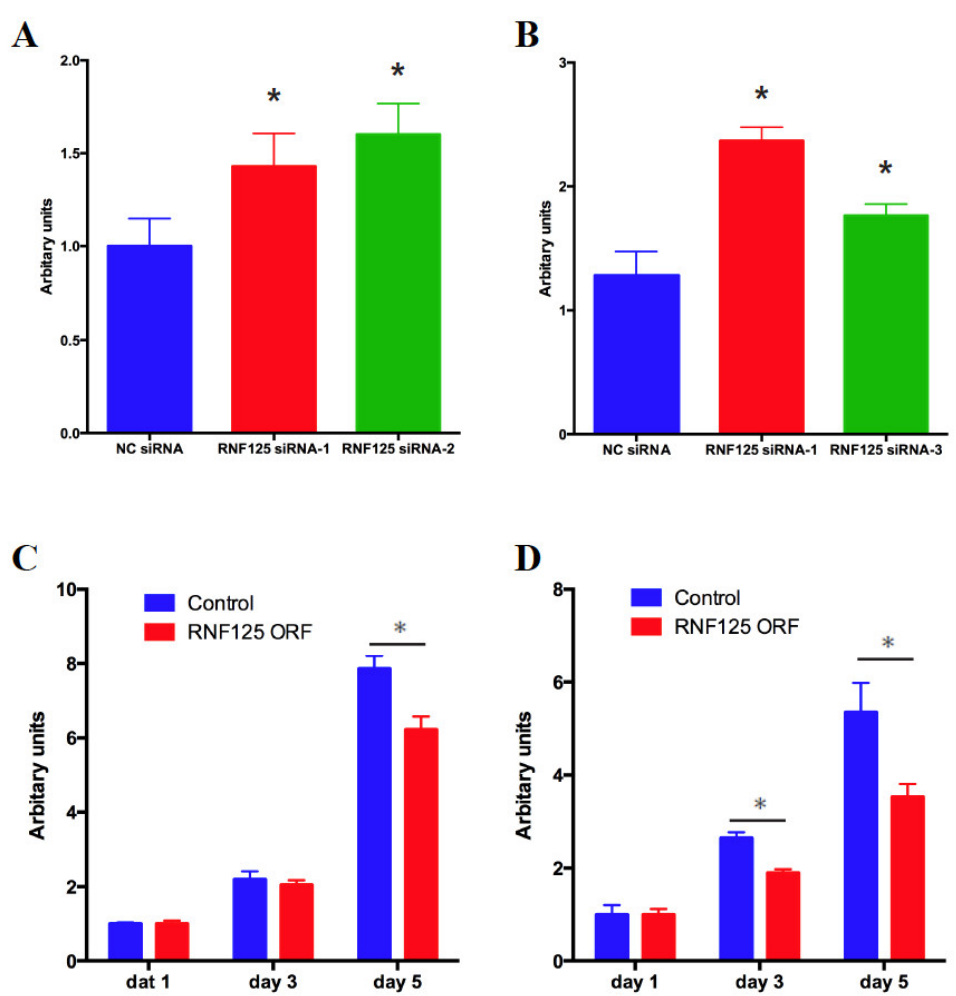
Figure 3. RNF125 inhibits HCC cell proliferation. HepG2 cells ( A ) and SNU-398 cells ( B ) were transfected with negative control (NC) siRNA or RNF125 siRNAs. WST-1 assay was used to measure the proliferation of these cells 4 days after transfection (* p < 0.05). PLC/PRF/5 cells ( C ) and Hep3B cells ( D ) were lentivirally transduced with control vector or RNF125 expression vector. Cell proliferation was assessed by WST-1 assay (* p < 0.05).